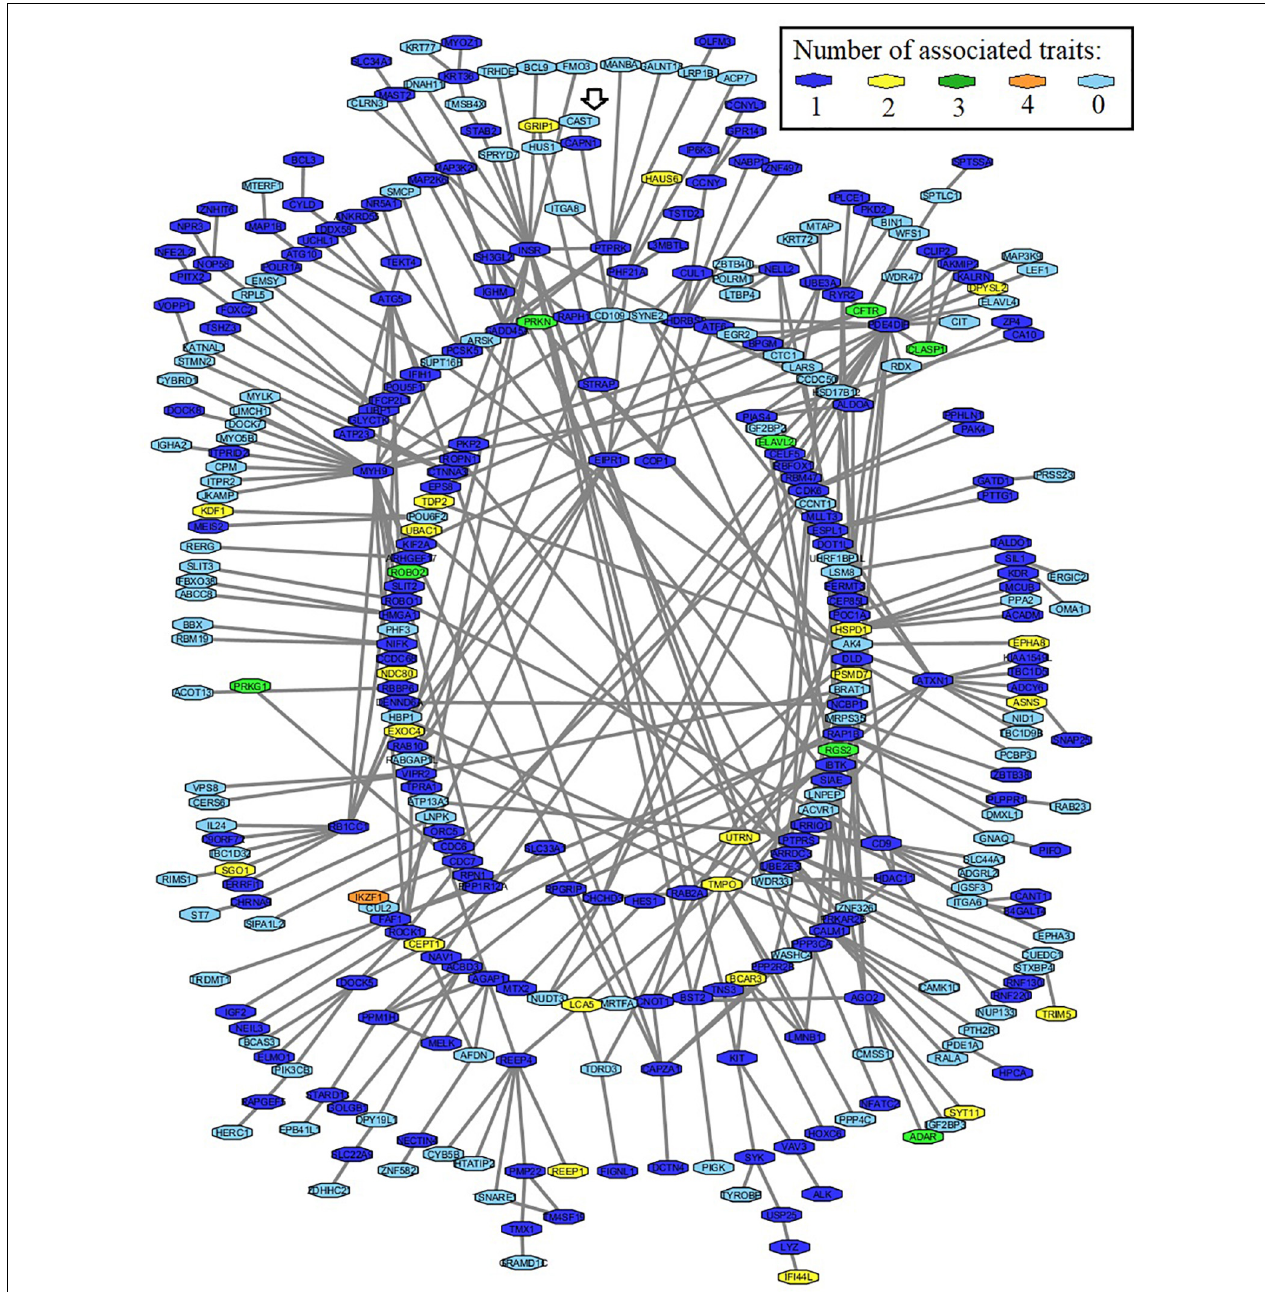
FIGURE 4 | Protein–protein interaction network, including 260 associated genes for marbling, WBSF, tenderness, and connective tissue, and 89 additional non-associated genes (light blue nodes). The phenotypic data was recorded on an Angus population. The arrow shows the µ -calpain - CAST system.